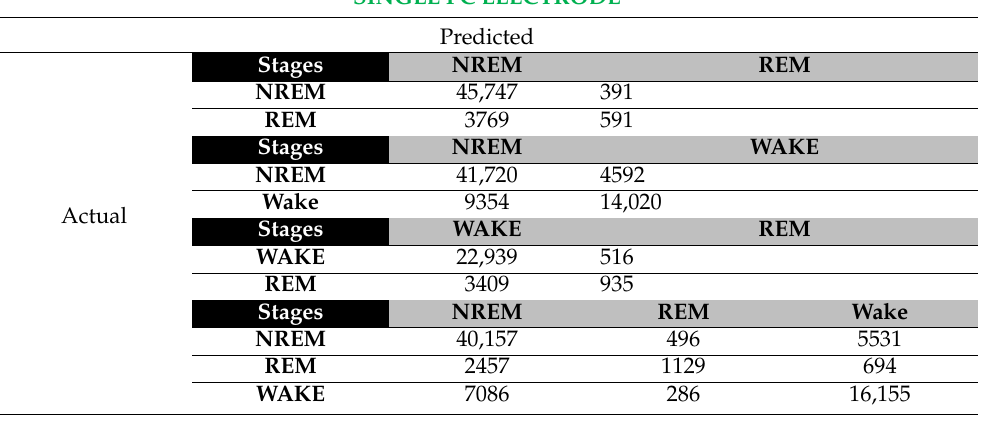
Table 9. Confusion